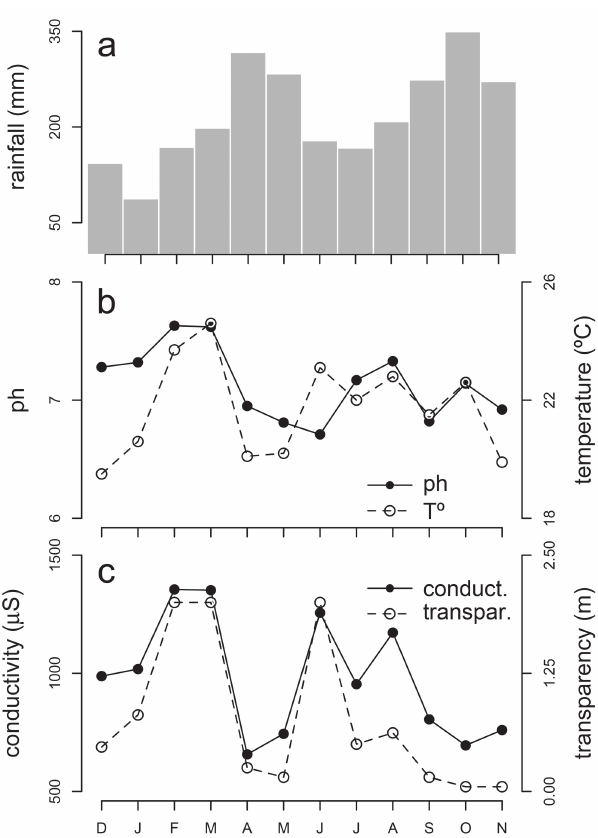
Fig. 1. Monthly variation of environmental variables: (a) rainfall pattern, (b) pH and temperature, and (c) conductivity and transparency.